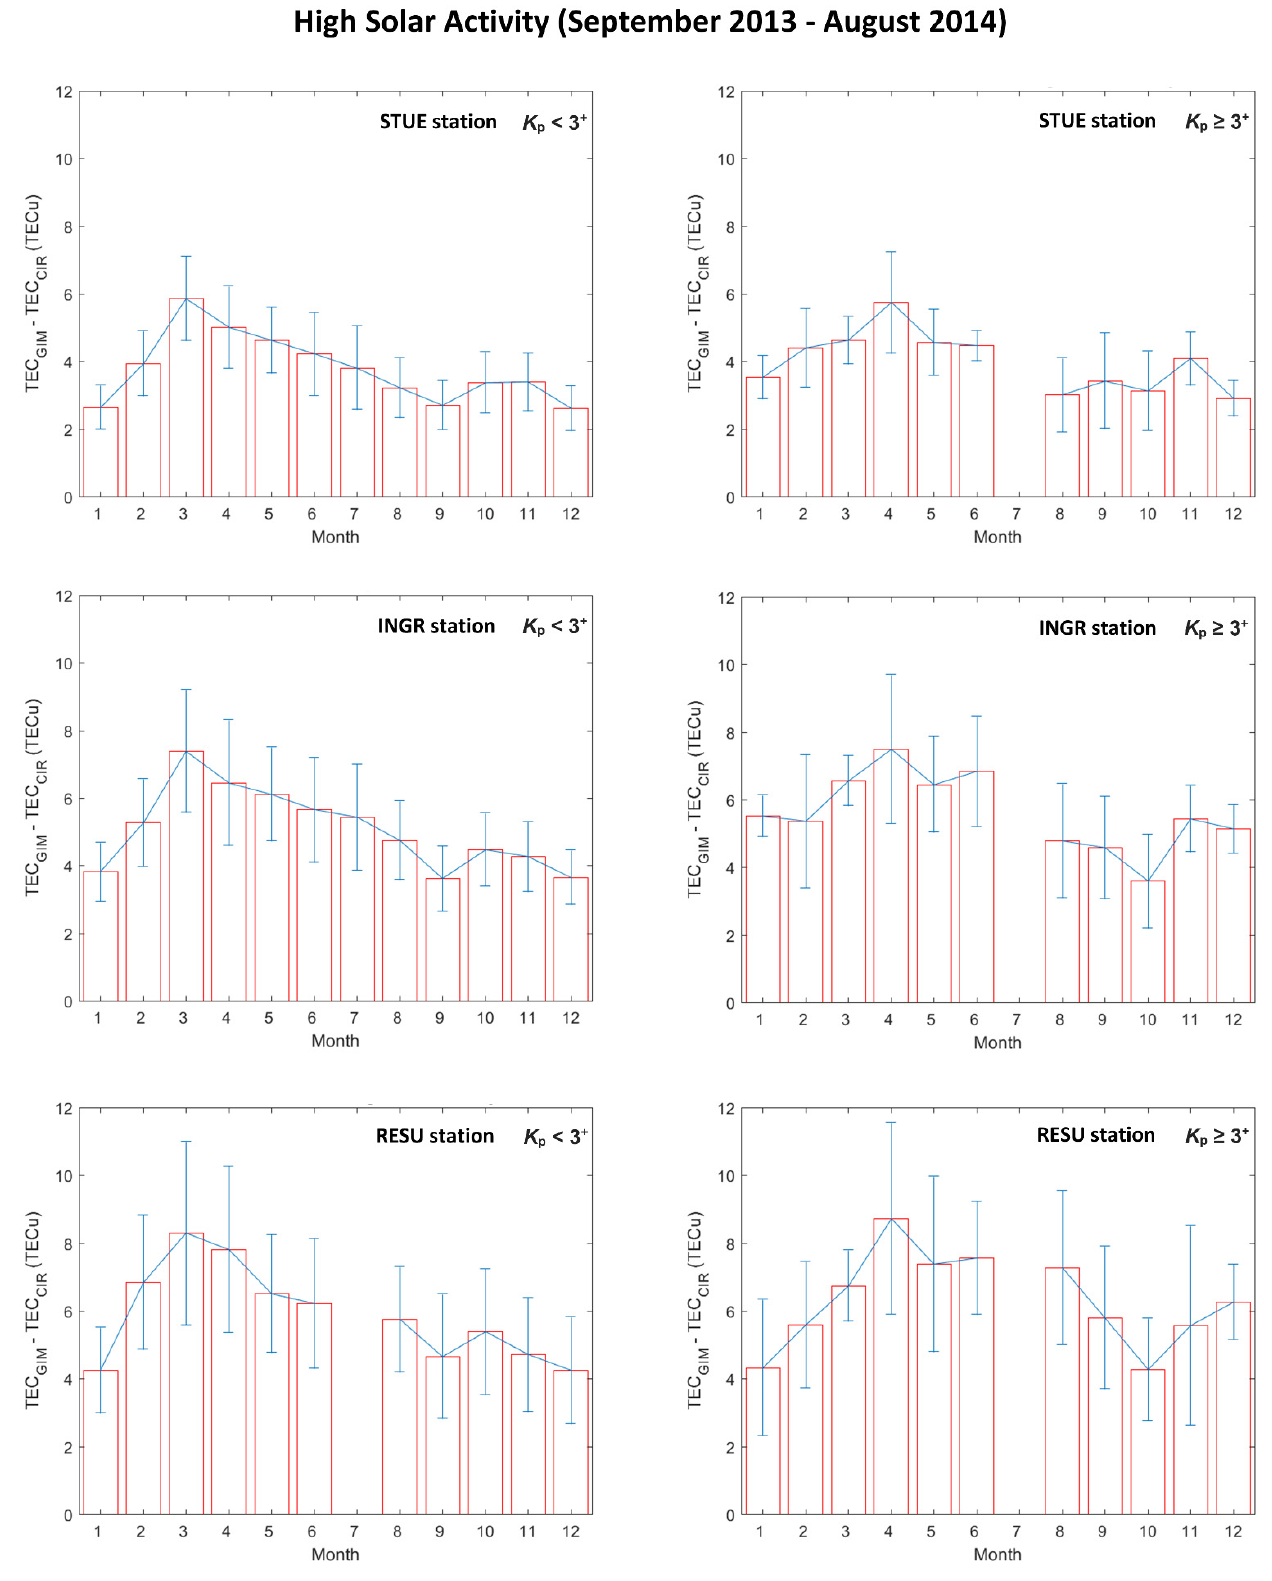
Figure 8. Mean monthly variation of the difference (TEC GIM - TEC CIR ), and corresponding standard deviation, for STUE (upper row), INGR (middle row) and RESU (lower row) for the HSA period between September 2013 and August 2014. Left panels refer to quiet geomagnetic values ( K p < 3 + ), while right panels refer to disturbed geomagnetic values ( K p ≥ 3 + ).